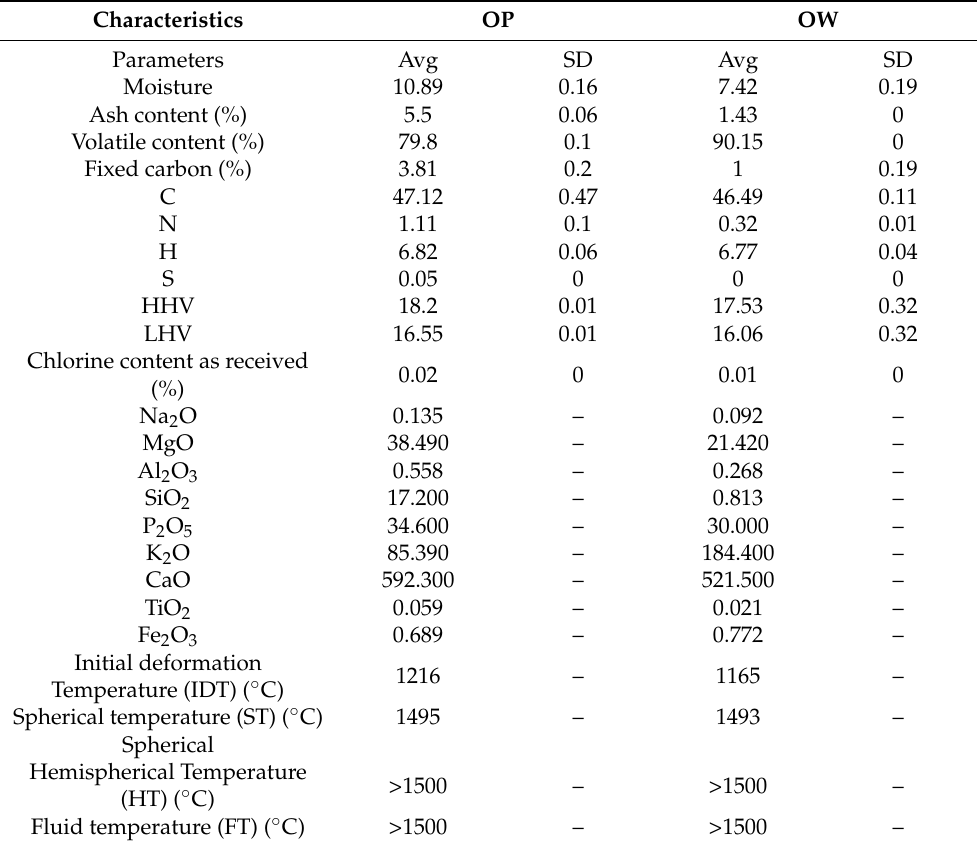
Table 3. Characteristics of olive pruning (OP) and olive wood (OW) pre-pelletizing.